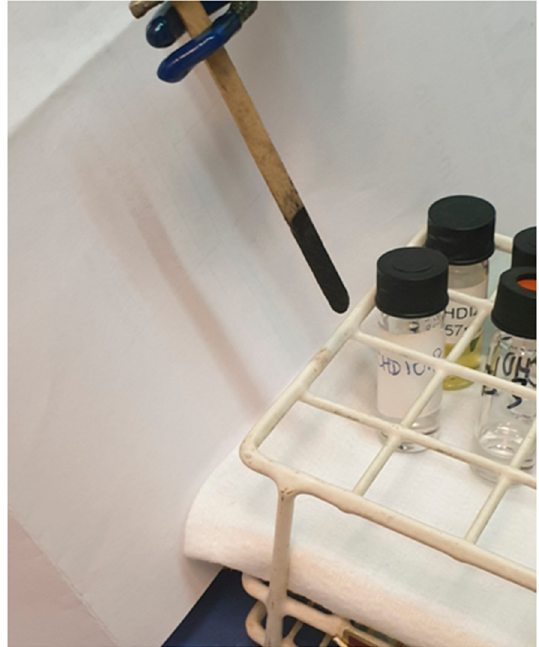
Figure 1. Coated graphene oxide/polyethylene glycol (GO/PEG)-Stick .